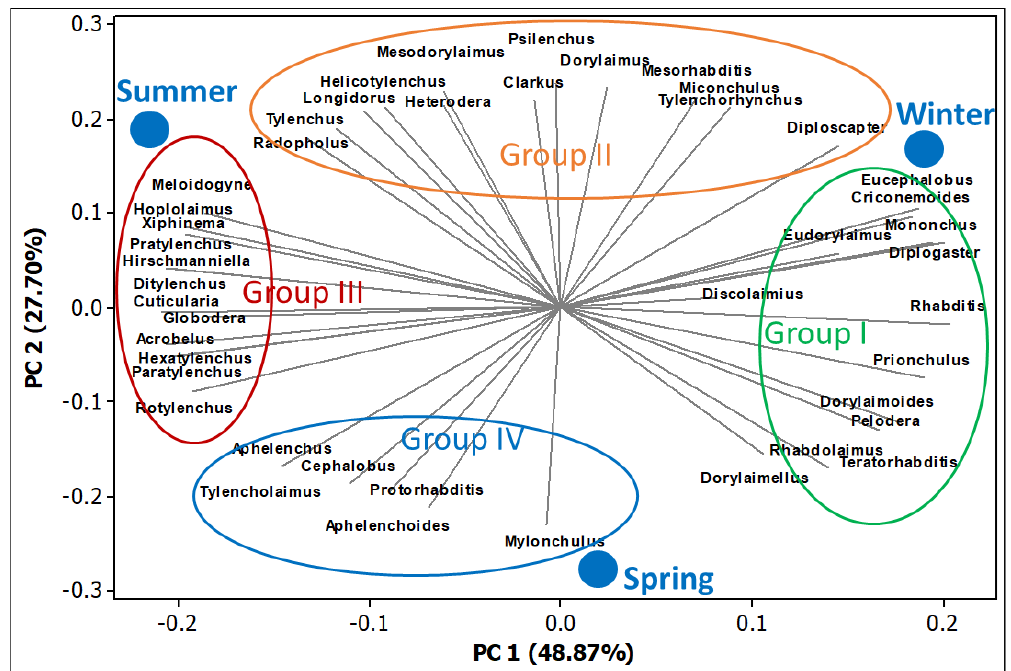
Figure 7. Principal component analysis (PCA) of soil nematode genera during the three seasons: spring, summer, and winter. The PCA shows the season’s position according to nematode diversity and the contribution of the nematode genera in the four groups .